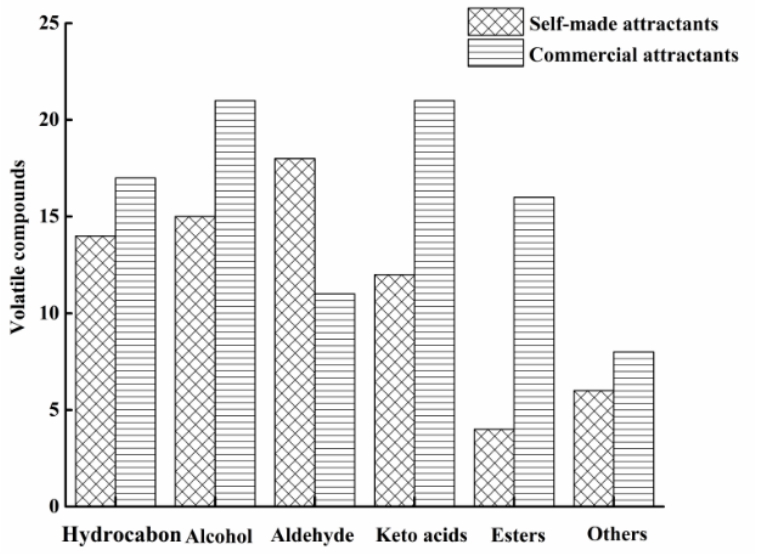
Figure 1. Composition of volatile compounds in self-made and commercial attractants.